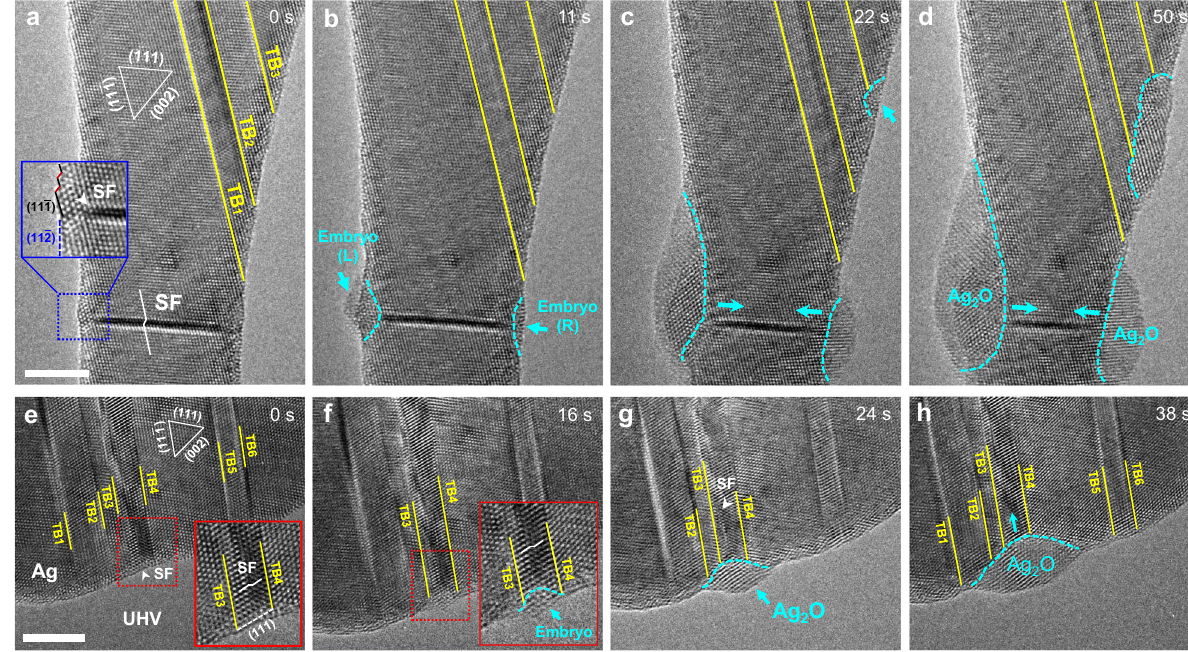
Fig. 3 Selective oxidation of Ag nanocrystals with different planar defect con fi gurations. a – d Preferential oxidation of an Ag nanocrystal with an isolated SF. a , b Two oxide embryos formed preferentially at the SF-surface junctions on both sides (indicated by the light blue arrows), while the TB-surface junctions remained intact. Inset in a shows the atomistic structure of the surface near the SF, which consists of atomically fl at (11 (cid:1) 2) plane and several (11 (cid:1) 1) kink steps. c , d Subsequent SF-assisted fast inward and lateral growth of Ag 2 O island. Meanwhile, oxide nucleation and growth was initiated at the TB 3 - surface junction away from the SF. e – h Preferential oxidation in an Ag nanocrystal with unevenly spaced planar defects. e Multiple parallel TBs (#1 – 6) and a SF (indicted by the white arrow) pre-existed in the as-fabricated Ag nanocrystal with a clean surface. f Oxide embryo nucleated preferentially at the SF- surface junction. g Inward growth of the Ag 2 O island along the SF plane. h Integrated inward and lateral growth of the Ag 2 O oxide with the annihilation of the SF. No evident oxidation was observed at the TB-surface intersection sites nearby. Insets in e , f are zoomed-in snapshots presenting the atomistic nucleation processes of the oxide embryo at the SF-(111) surface facet junction. Scale bars in a and e : 5